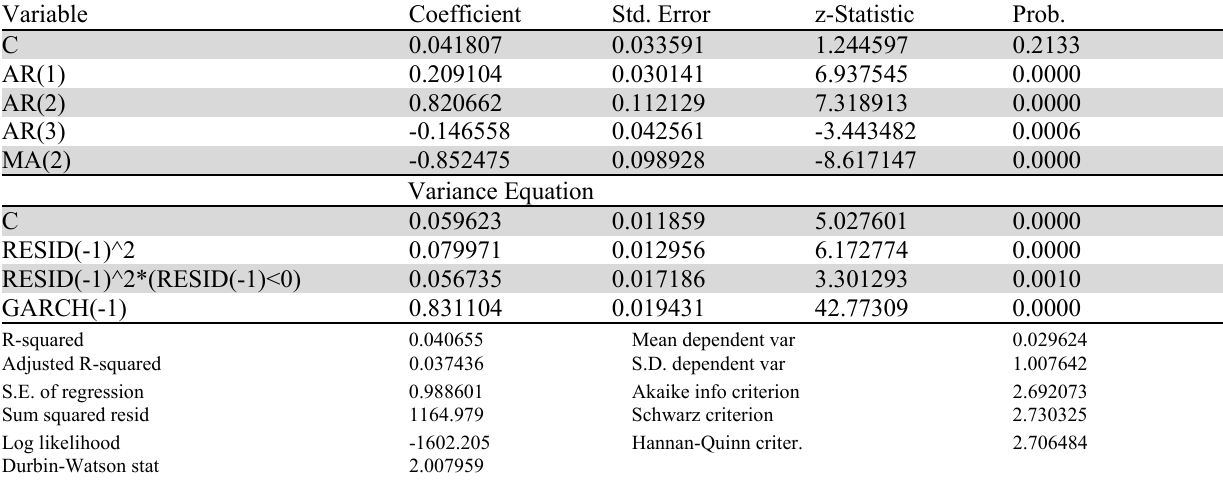
The results of TARCH model on oil